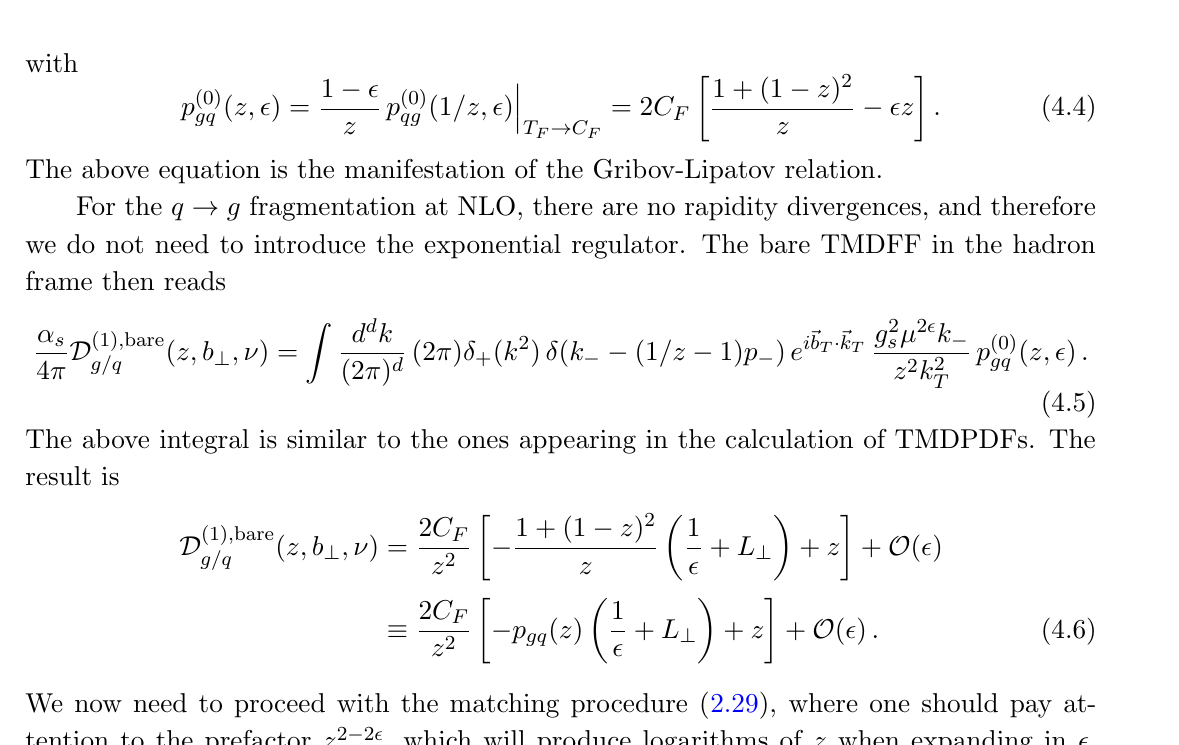
Figure 7 . Cut diagram for the bare q